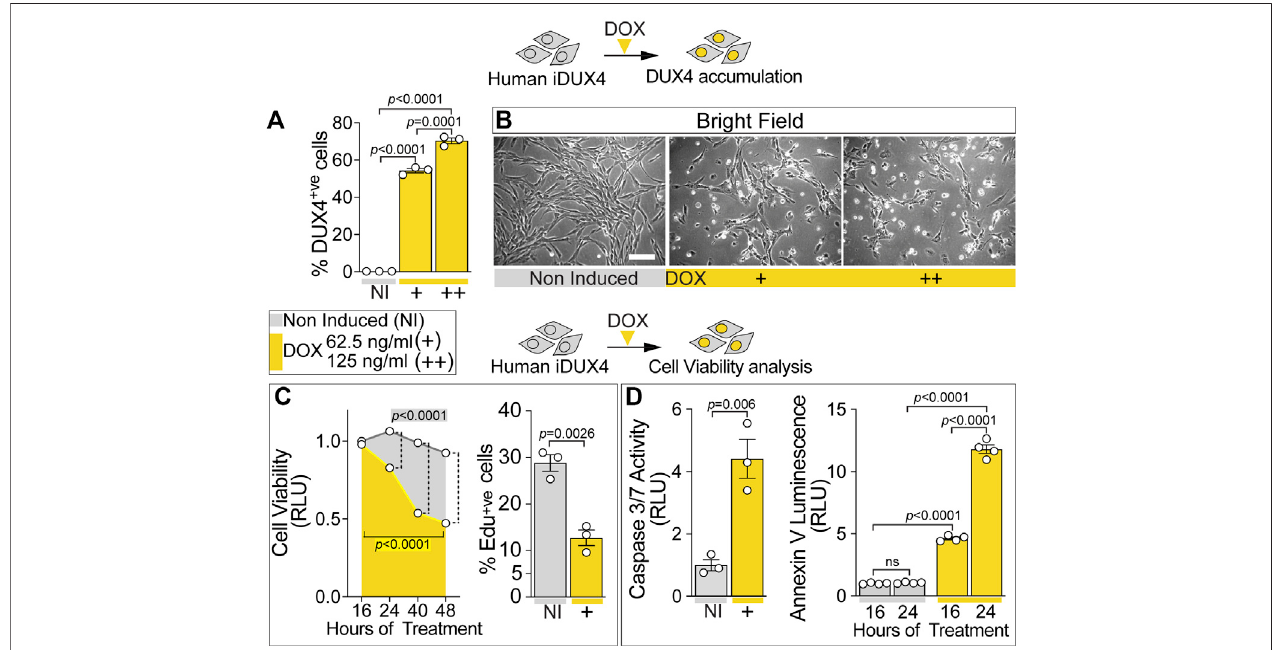
FIGURE 1 | DUX4 blocks proliferation and triggers cell death in human myoblasts. (A) Percentage of iDUX4 myoblasts containing DUX4 (DUX4 +ve ) showing dose- dependent effect of Doxycycline (DOX) (+: 62.5 ng/ml; ++: 125 ng/ml) for 24 h compared to non-induced control (NI), N = 3 biological replicates, unpaired t-test. (B) Representative bright fi eldimages ofproliferating human iDUX4 myoblasts inducedwith 62.5 ng/ml(+) or 125 ng/ml (++)DOX for 24h, showingreductionin cell viability upon DUX4 accumulation. Scale bar equals 100 µm. (C) Quanti fi cation of cellular viability following DUX4 induction (+: 62.5 ng/ml DOX) shows persistent decline over time compared to non-induced iDUX4 cells (left). N = 4 biological replicates, ANOVA, Tukey ’ s posthoc test for viability. Highlighted p values indicate signi fi cance between 16 and 48 h of DOX treatment (yellow) or in overall viability trend between non-induced and induced cells. Vertical dashed lines indicate p values < 0.0001 between non-induced and induced samples at given time points. RLU; Relative Luciferase Units reported as fold change to non-induced (NI) 16 h sample. Percentage of iDUX4 myoblasts that had incorporated EdU (EdU +ve ) was signi fi cantly reduced upon 24 h of DUX4 induction (right). N = 3 biological replicates for EdU, unpaired t-test. +: 62.5 ng/ml DOX. (D) Quanti fi cation of Caspase3/7 activity upon DOX treatment shows signi fi cant increase in DUX4-induced cells (+: 62.5 ng/ml) compared to non-induced control (left). N = 3 biological replicates, unpaired t-test for Caspase 3/7. DUX4 accumulation leads to increased apoptosis over time, as shown by increased Annexin V (right). N = 4 biological replicates, ANOVA, Tukey ’ s posthoc test. RLU; Relative Luciferase Units reported as fold change to non-induced (NI) 16 h sample. Graphs report mean ± SEM from representative experiments. Statistical signi fi cance between speci fi c samples indicated by a